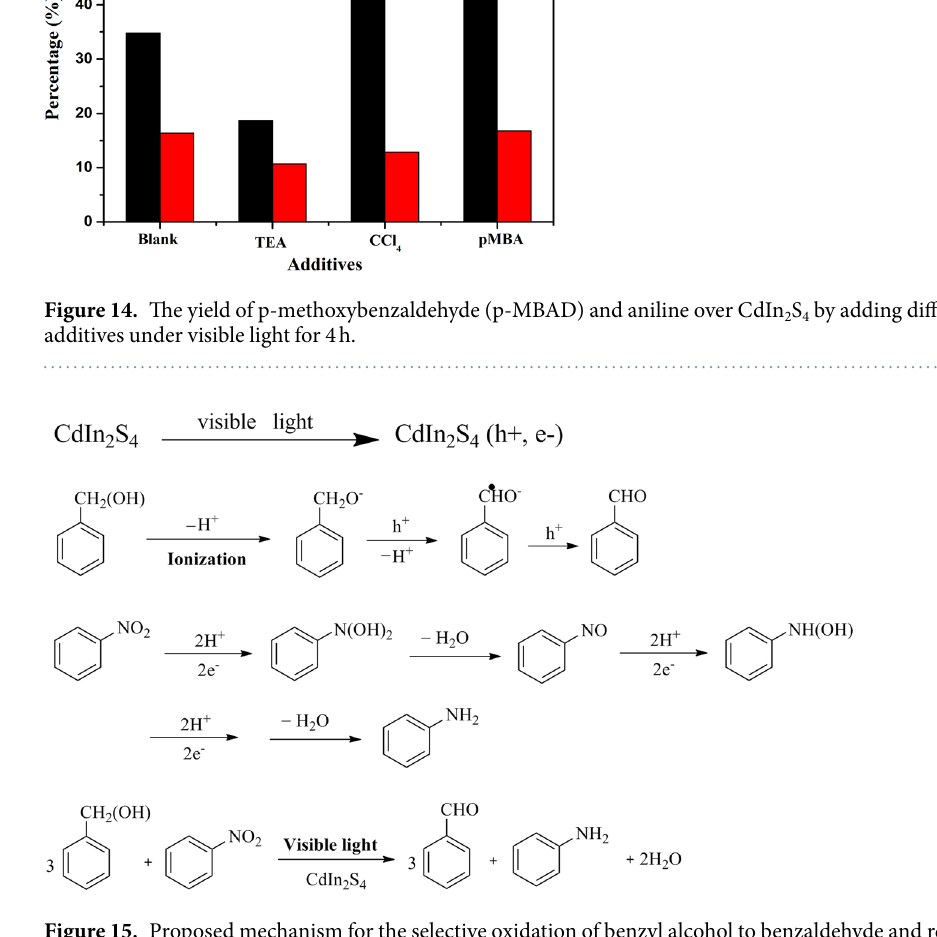
12 Scientific RepoRts | 7: 27 | DOI:10.1038/s41598-017-00055-5